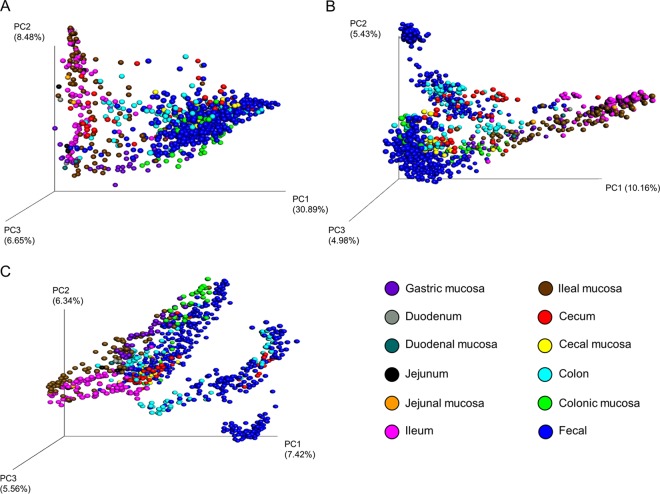
Principal-coordinate analysis plots of weighted UniFrac distances (A), unweighted UniFrac distances (B), and Bray-Curtis dissimilarities (C) classified by gastrointestinal tract sample type. The percentages of variation explained by the principal coordinates are indicated on the axes.